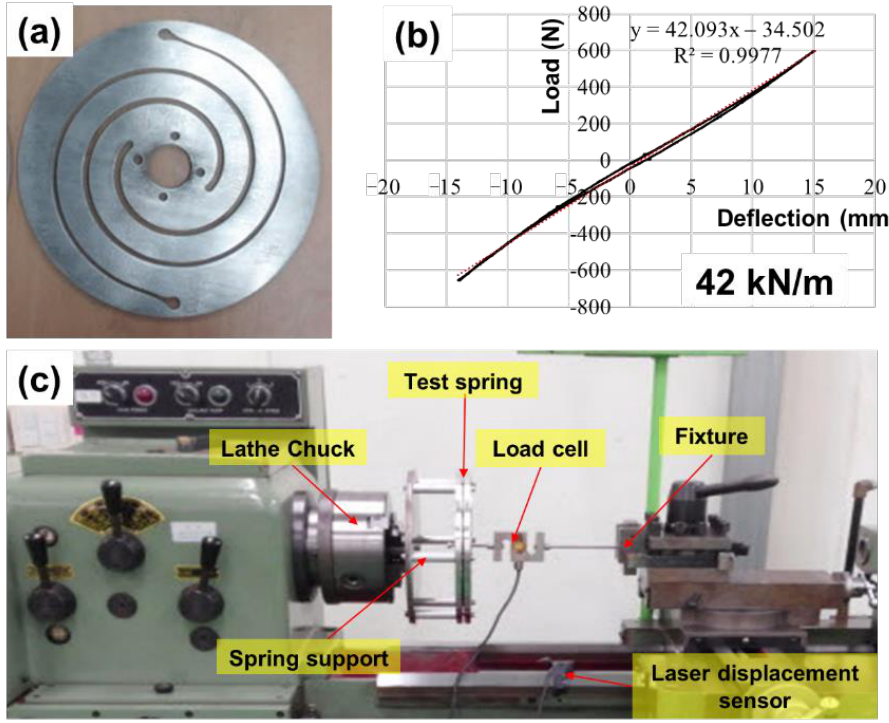
Figure 3. Static load-deflection tests of flexure spring: ( a ) manufactured spring, ( b ) measured force–displacement during consecutive pushes and pulls, and ( c ) the test rig using a lathe. As a result, the test spring deflects with maximum bidirectional deformations of ± 15 mm with proper linearity and negligible hysteresis, satisfying the piston’s design amplitude of 12 mm. The measured spring stiffness is 42 kN/m. Note that the spring was designed through finite element stress analyses, which are omitted for